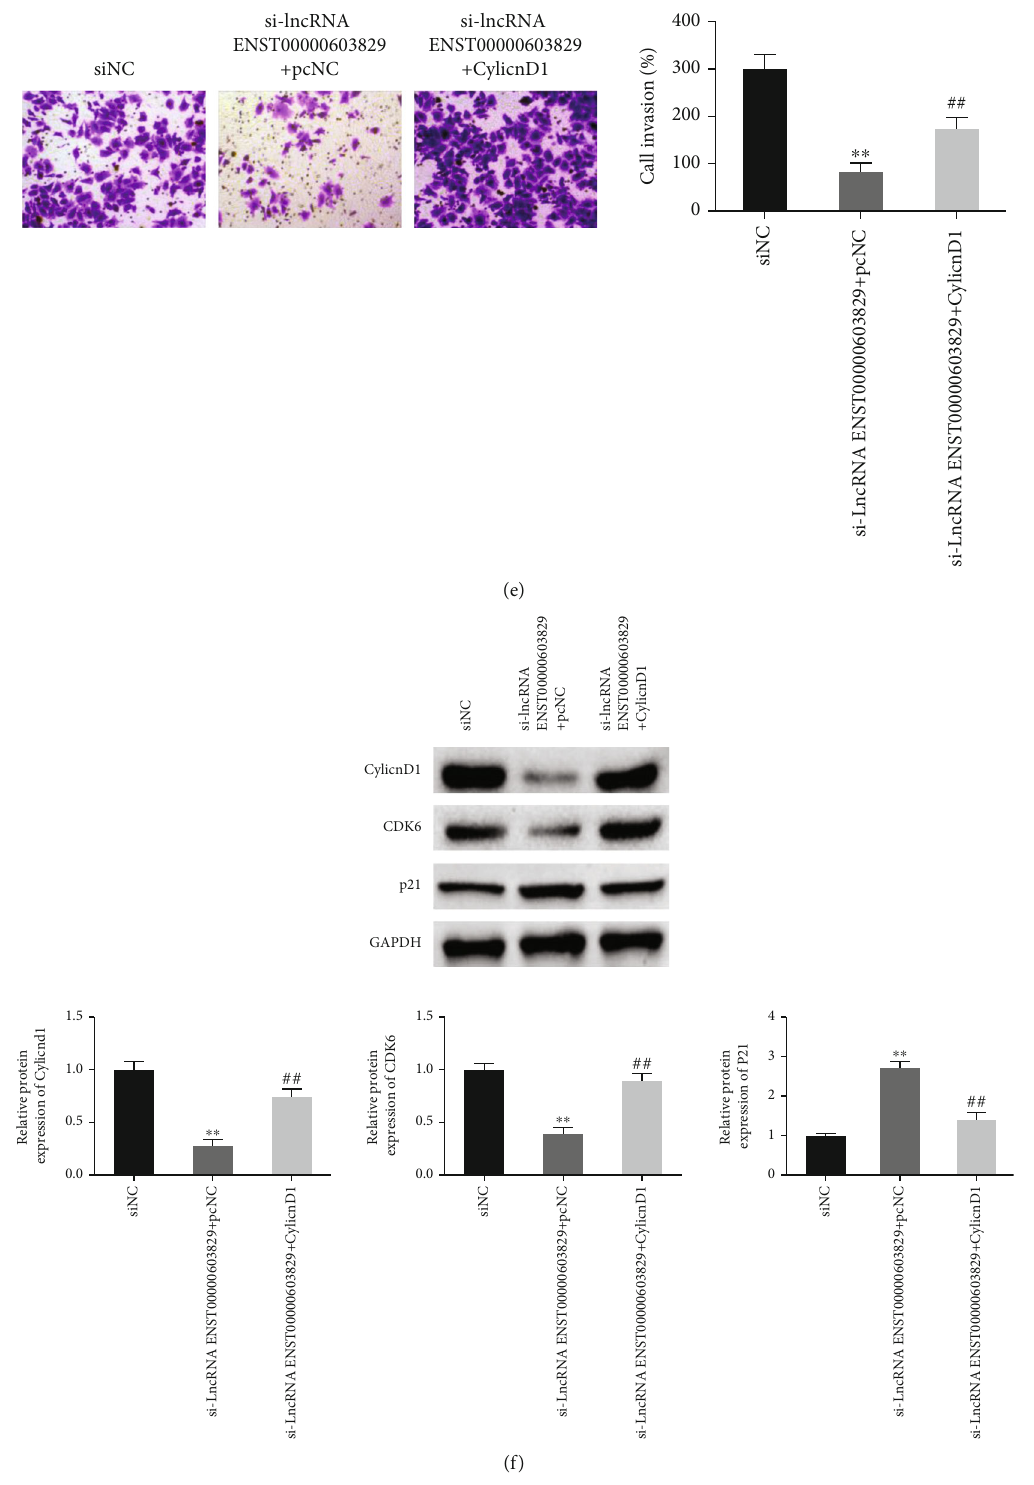
Figure 4: E ff ect of cyclin D1 upregulation on tumor inhibition after knockdown of lncRNA ENST00000603829. qRT-PCR assay for cyclin D1 expression in cells; (b) CCK-8 assay to examine the cell proliferation rate; (c, d) fl ow cytometry was used for assessing the (c) cell apoptosis rate and (d) cell cycle; (e) transwell assay for invasion ability of cell; (f) Western blot assay for expression of cell cycle-related proteins (cyclin D1, CDK6, and p21). ∗∗ p < 0 : 01 vs. the siNC group, ## p < 0 : 01 vs. the si-lncRNA ENST00000603829+pcNC